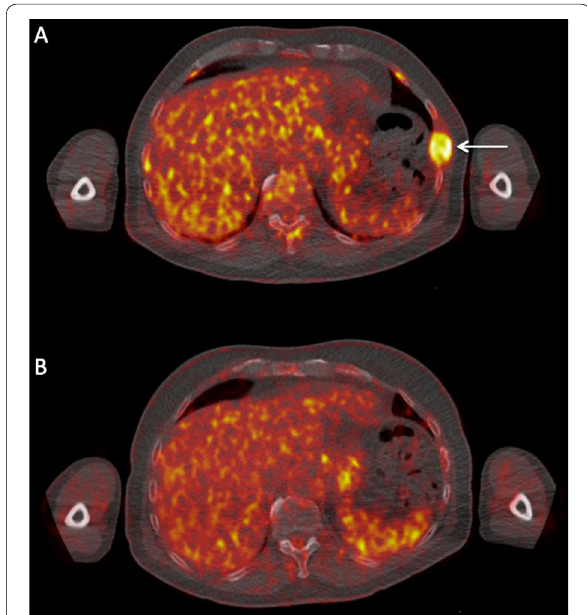
Fig. 2 Transaxial PET/CT images at the thoracic level of a 70‑year‑old, male MM patient before and after therapy. A Baseline PET/CT revealed a hypermetabolic, focal lesion in the 8th left rib with cortical bone interruption and involvement of the surrounding soft tissues (arrow) as a sign of PMD. B After completion of HDT and ASCT, follow‑up PET/CT revealed a complete metabolic remission of the former hypermetabolic PMD and development of a rib fracture